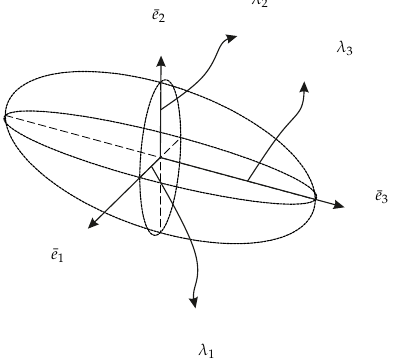
Figure 3. Illustration of eigenvalues ( λ i for i = 1,2,3) and eigenvectors (¯ e i for i = 1,2,3) as an ellipsoid for a 3 × 3 stiffness